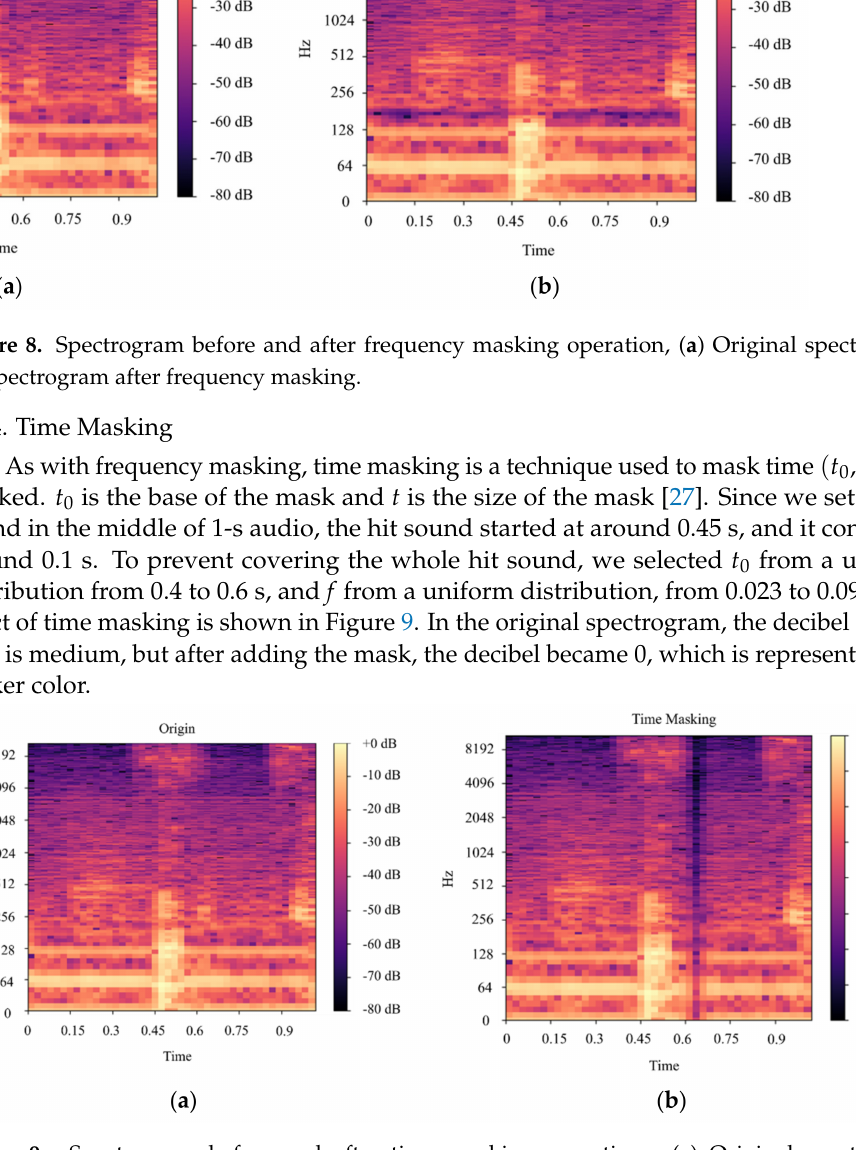
Figure 9. Spectrogram before and after time masking operation. ( a ) Original spectrogram, ( b ) spectrogram after time